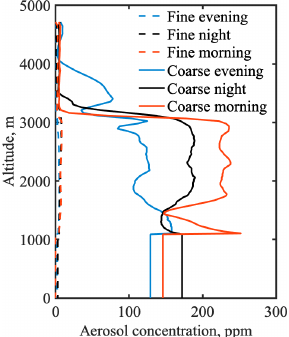
Figure 13. Aerosol vertical distribution for fine (dashed) and coarse (solid) aerosol components retrieved on 15–16 April 2015. Distri- butions retrieved before and after the advanced lidar observation in combination with photometer data are shown in blue and red, re-